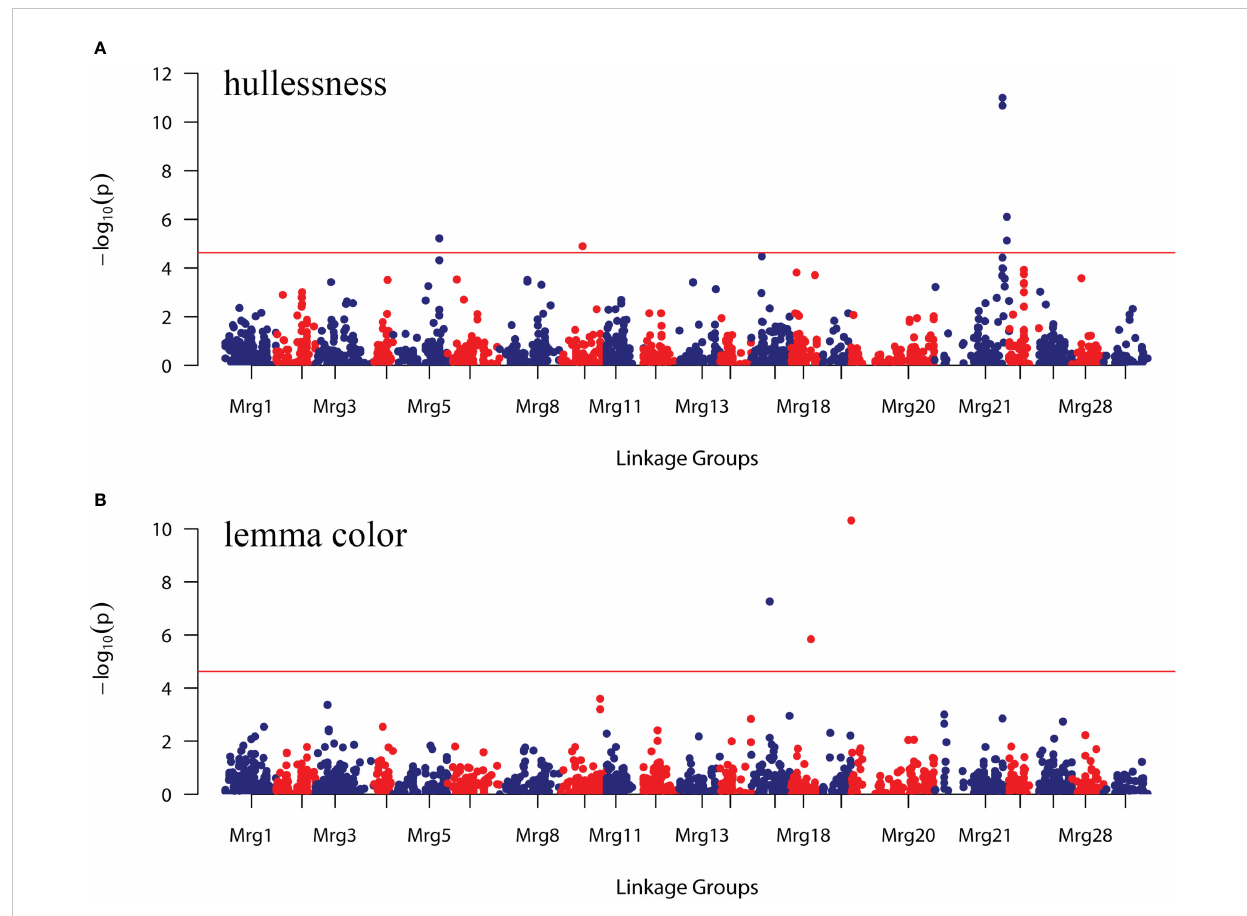
FIGURE 5 Genome-wide association study (GWAS) of the hullessness and lemma color traits in the oat collection using 2,143 SNP markers. (A) Hullessness; (B) lemma color. The red line represents the threshold calculated according to the false discovery rate (FDR). Markers above the red line in (A, B) were signi fi cantly associated with the respective trait.